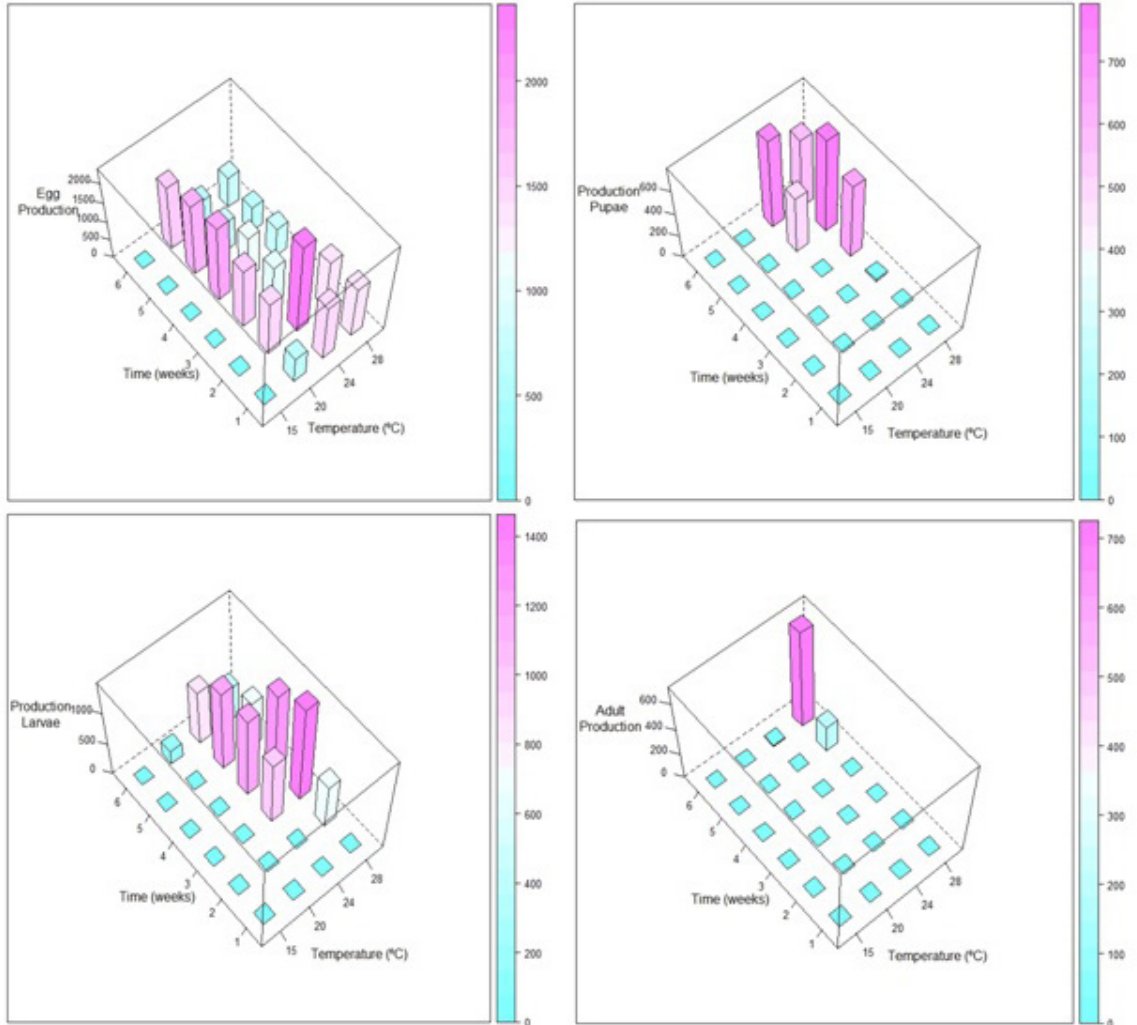
Fig 3. Eggs, larvae, pupae and adults produced by the queens in different temperatures (15°C, 20°C, 24°C e 28°C) during six weeks